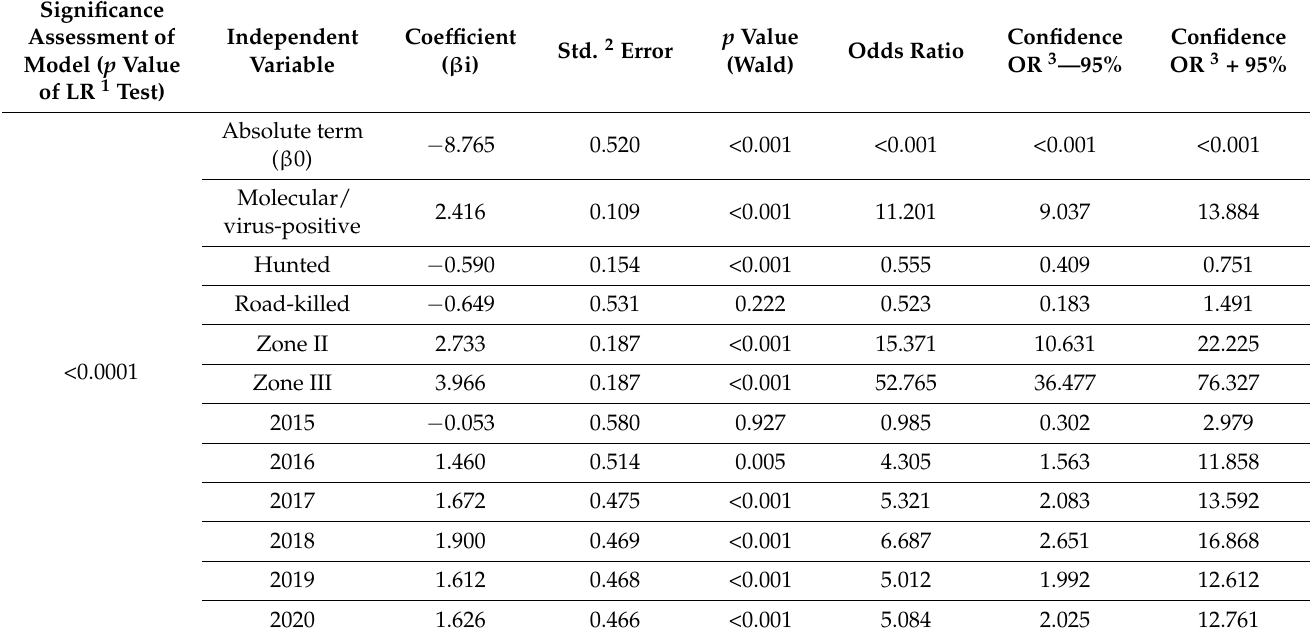
Table 1. Results of logistic regression models—impact of the type of result, animal status, ASF zone, and the year for the final serologically positive result (reference type of result: serologically